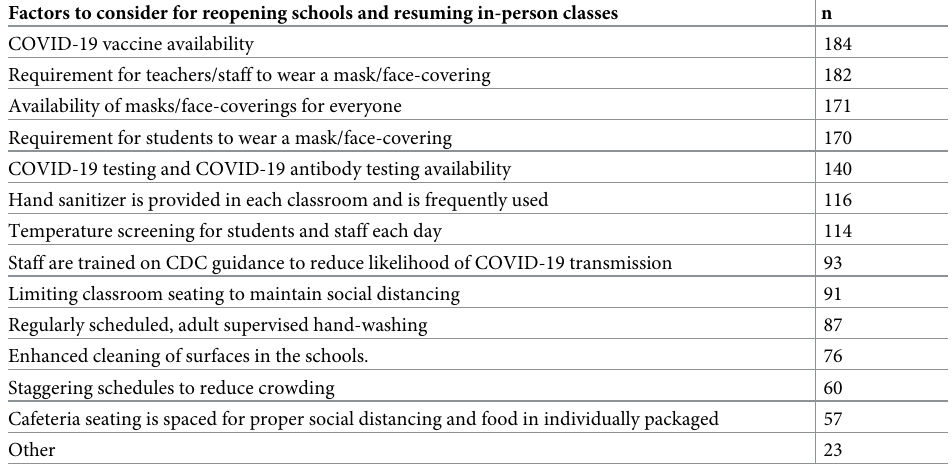
Table 4. Parents that selected one of the below factors as the top 5 priorities for reopening schools and resuming in-person